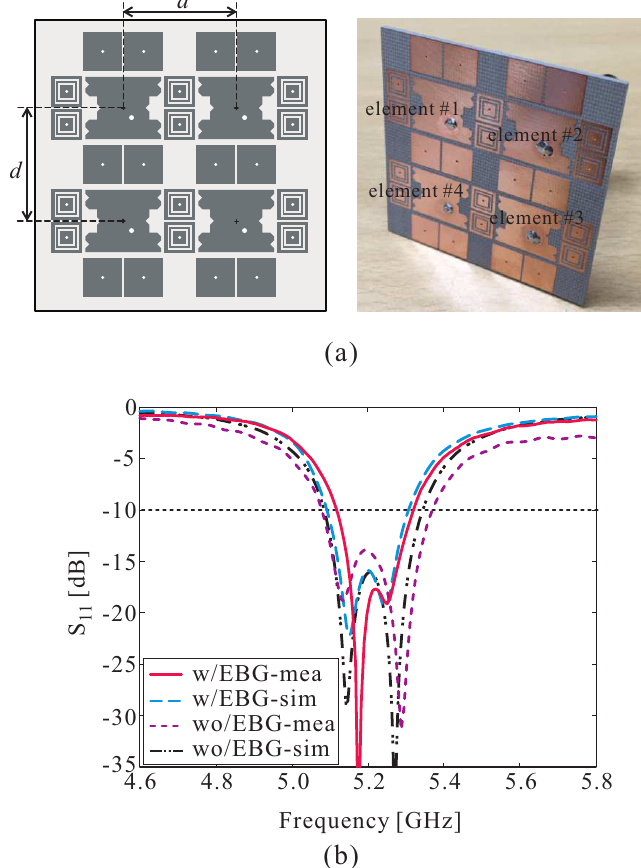
Figure 5. ( a ) The 2 × 2 array configuration for consideration of the mutual coupling and a photograph of the fabricated prototype; ( b ) Measured and simulated reflection coefficients of the 2 × 2 array with and without the